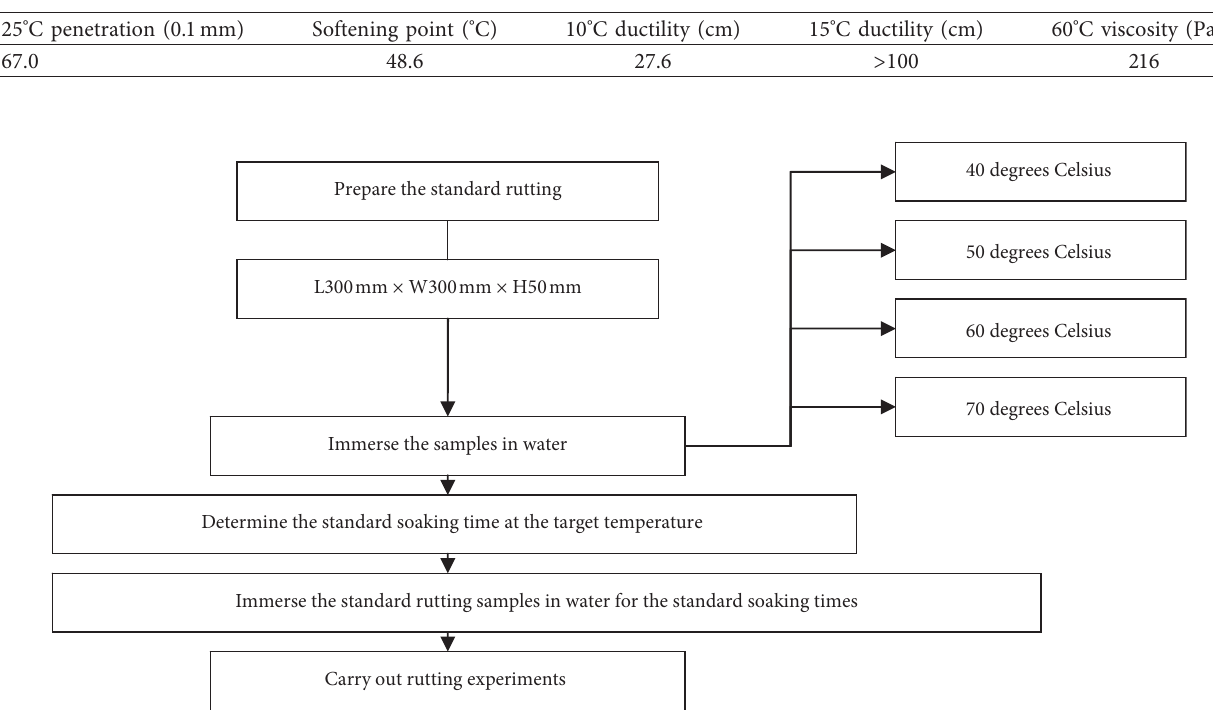
Table 5: Technical indexes of base asphalt binder.